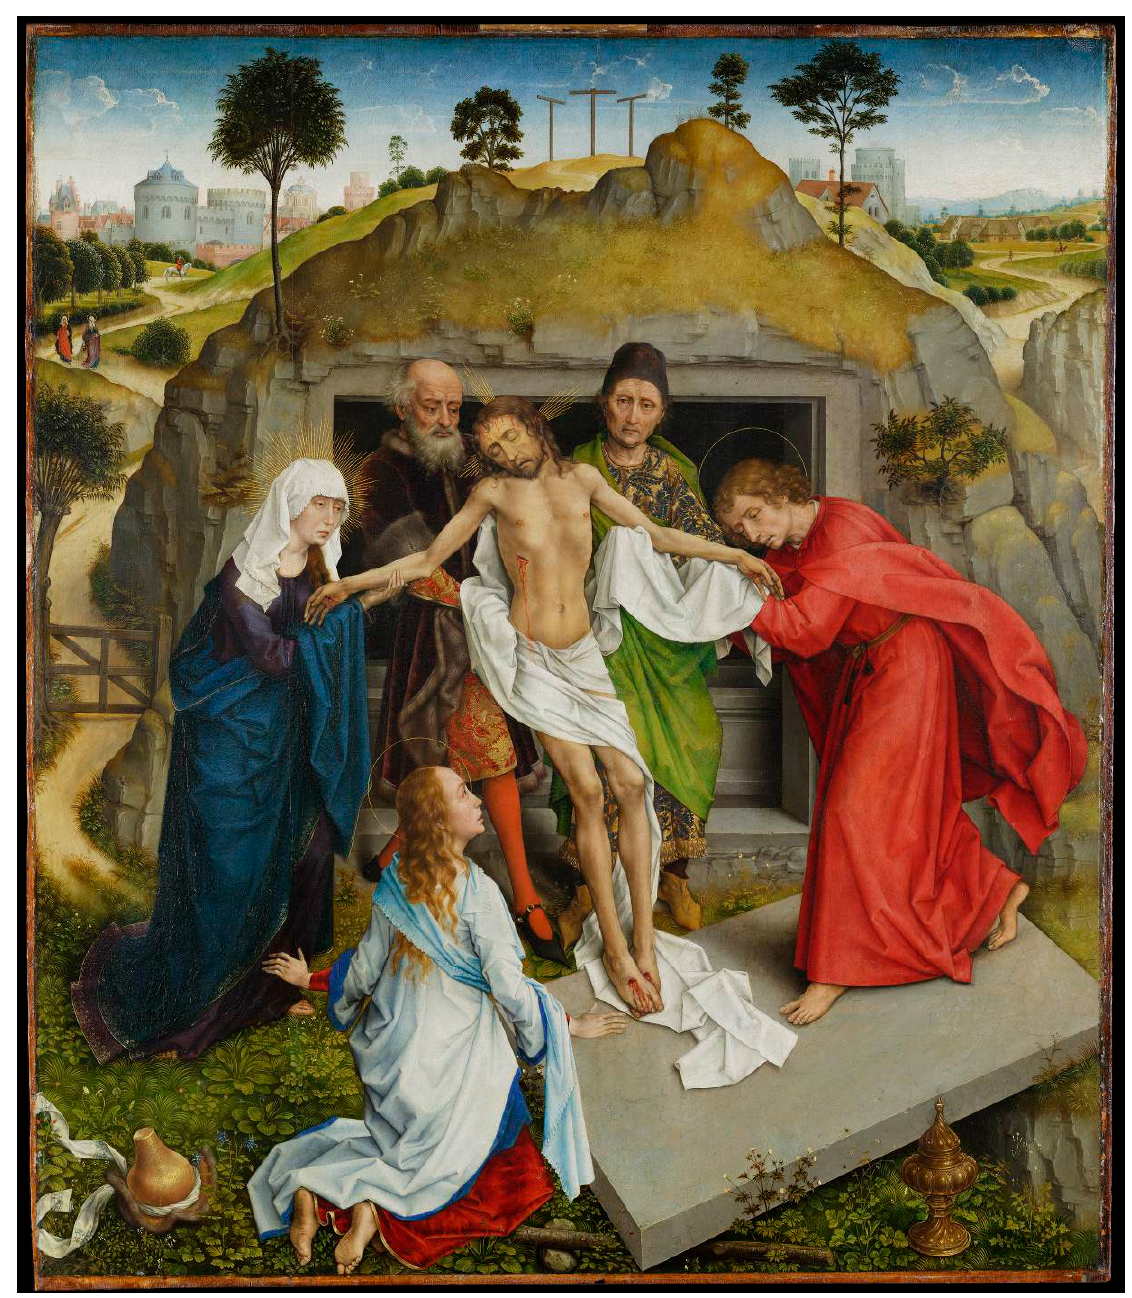
Figure 1. The Entombment of Christ by Rogier van der Weyden.